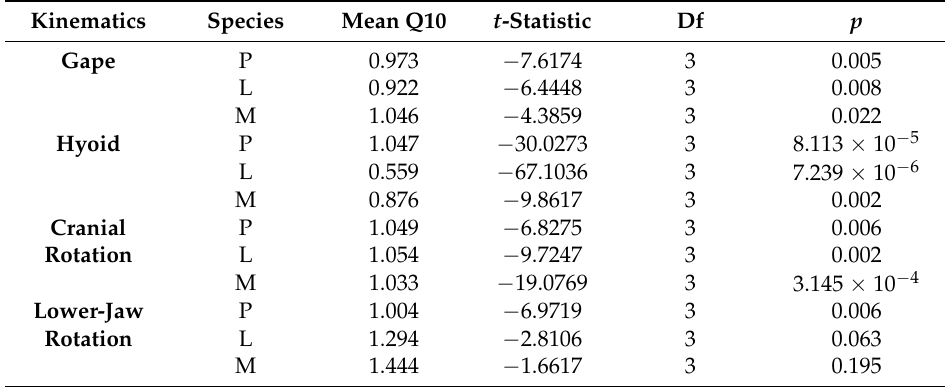
Figure 5. Mean Q10 values for kinematic-velocity in each of the three invasive-fish species. Note that except for the mean Q10 values for lower-jaw rotation in the Mayan cichlid and lionfish, all Q10 values of kinematic velocity were significantly less than the expected Q10 value of 2.0 for fish feeding at 20 ◦ C and 30 ◦ C. Error bars indicate standard error of the mean. Table 2. Results of the Paired t -Tests comparing the difference between mean Q10s of each of the kinematic velocity variables and the expected value of 2.0.